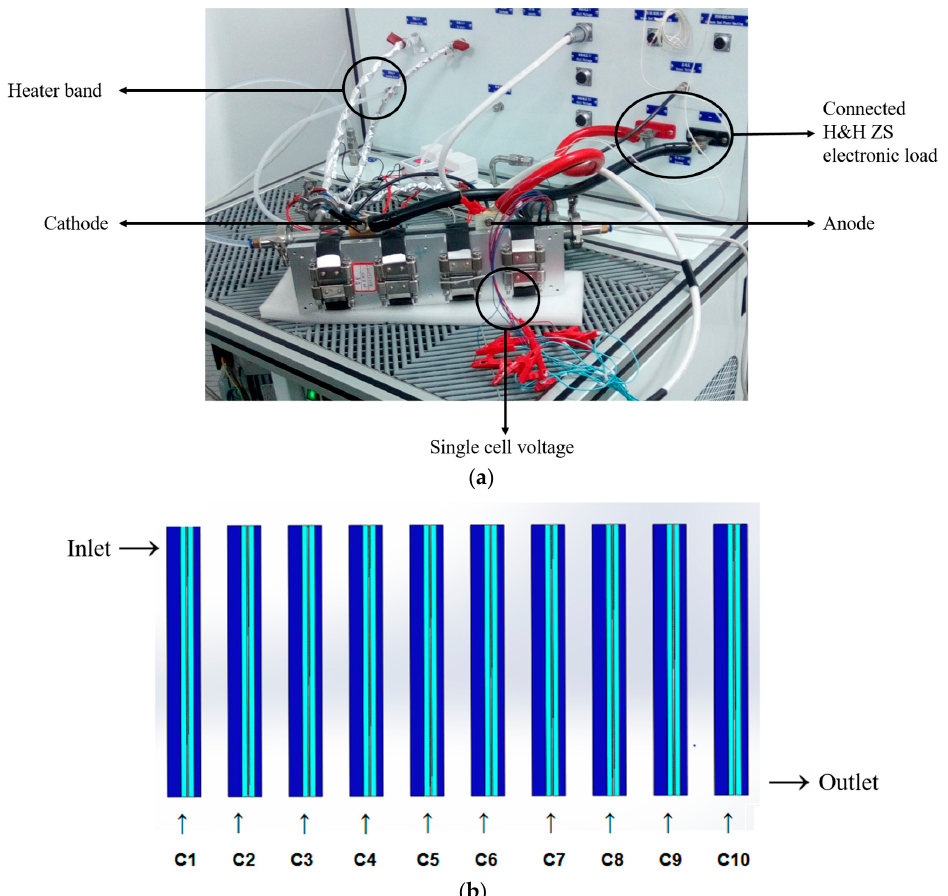
Figure 3. ( a ) Fuel cell stack and test platform; ( b ) Single cell distribution.